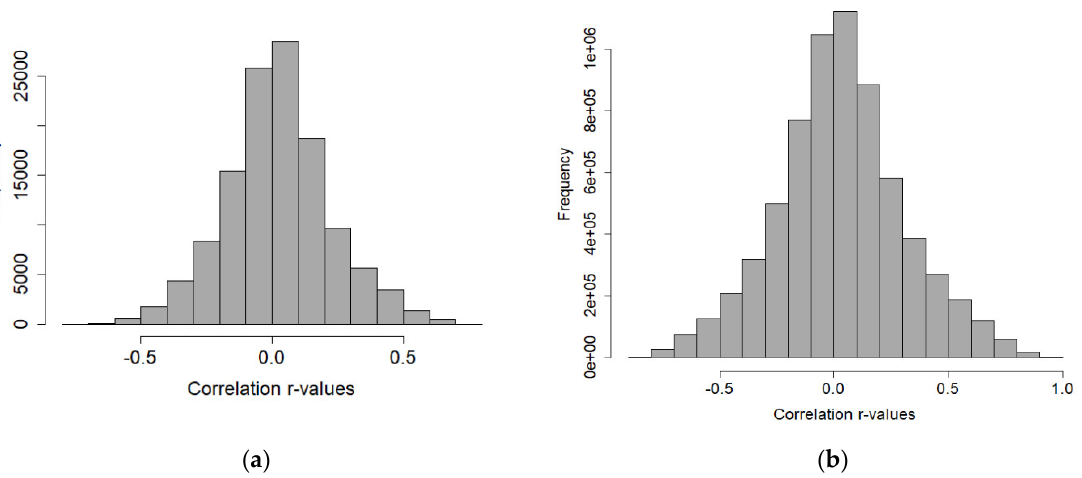
Figure A2. The frequency of the observed coefficient values resulting from the correlation of differentially expressed ( a ) MCTs and ( b ) ECMs with the rest of the transcriptome in PDAC stroma.